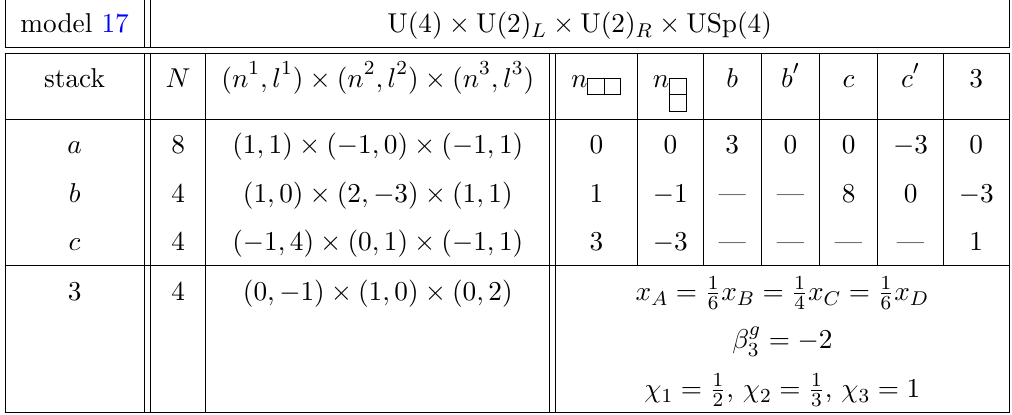
Table 17 . D6-brane configurations and intersection numbers of Model 17, and its MSSM